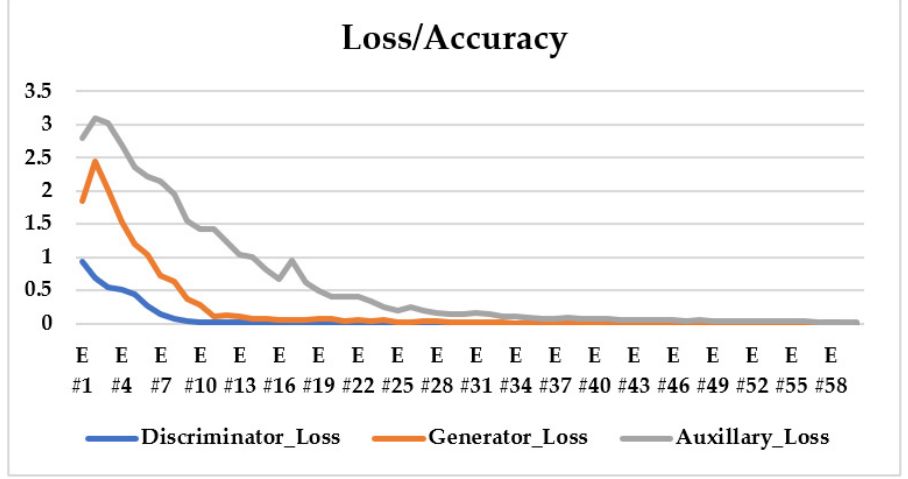
Figure 30. Loss/Accuracy curve for InfoGAN models training by ImageNet-sketch dataset.